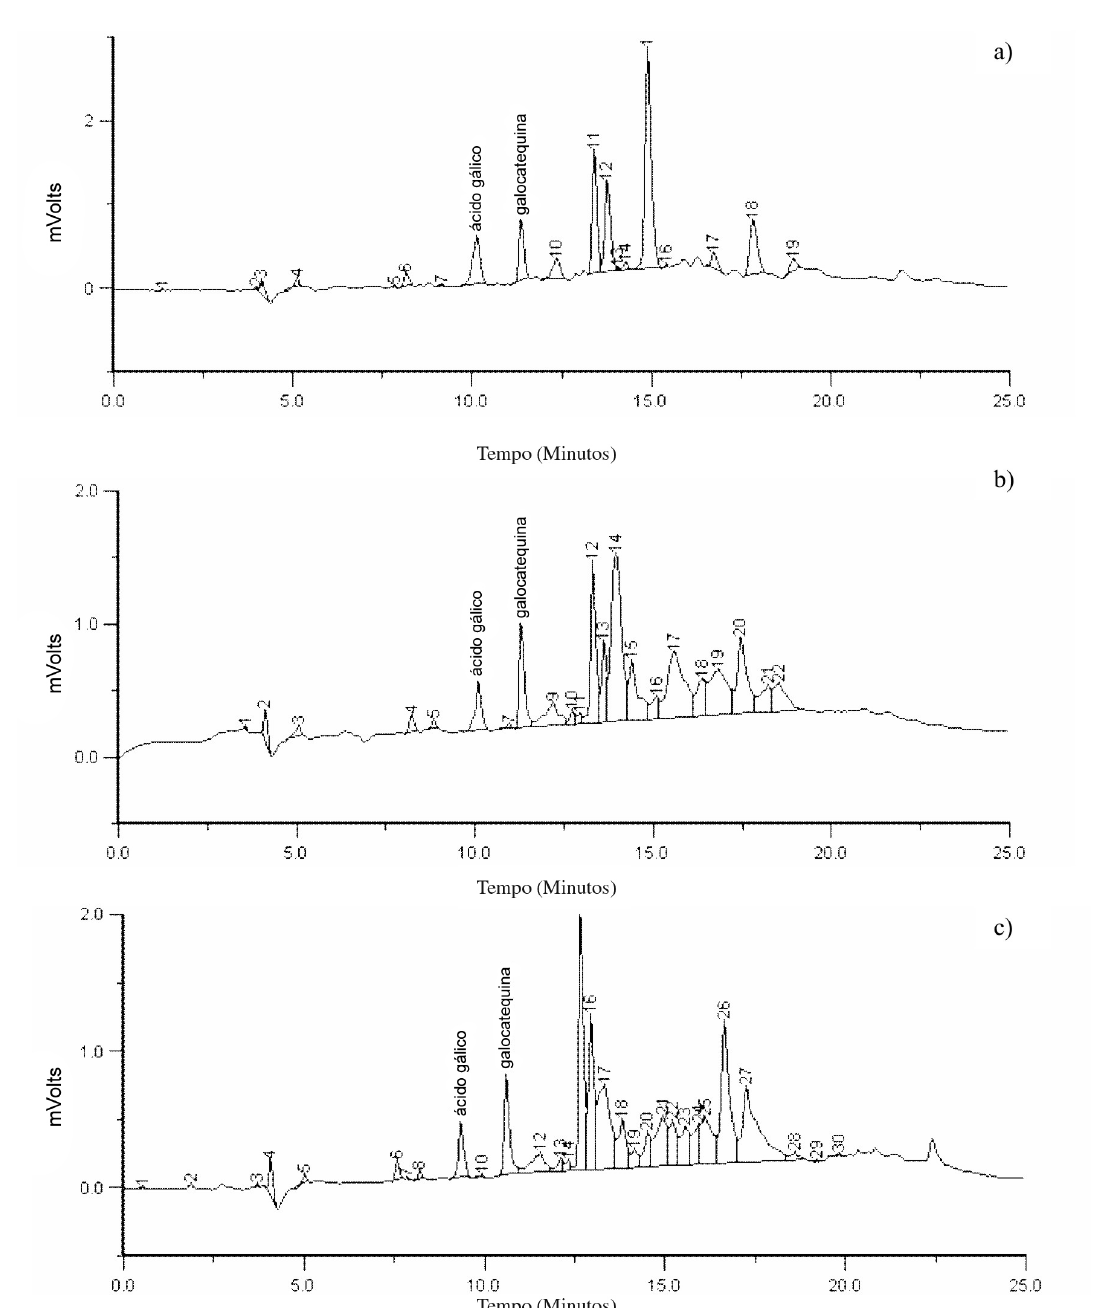
FIGURA 1 - Perfil cromatográfico a 210 nm do extrato semipurificado: a) S. adstringens, b) S. polyphyllum, c) S. obovatum . Picos correspondentes ao ácido gálico e galocatequina. Condições cromatográficas: pré-coluna (4 x 3 mm d.i., 5 µm), C-18, coluna